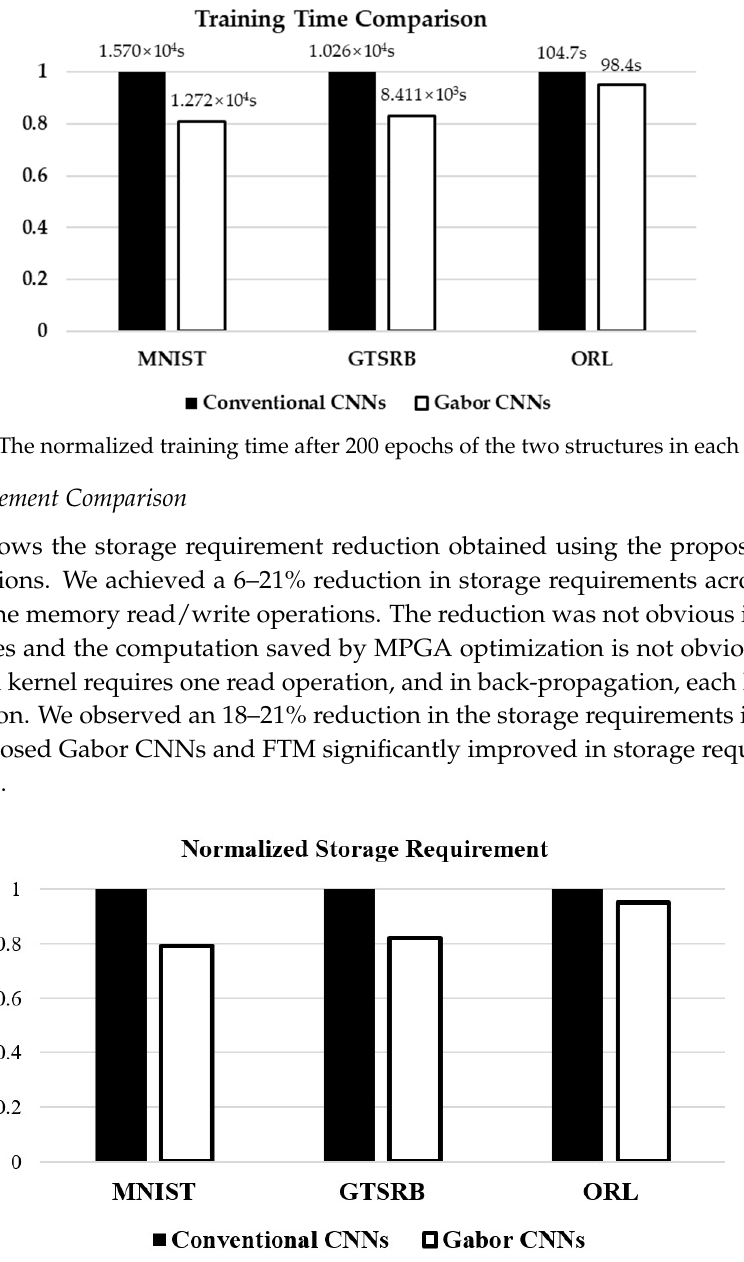
Figure 12. The normalized storage requirement reduction of the two structures in each dataset.